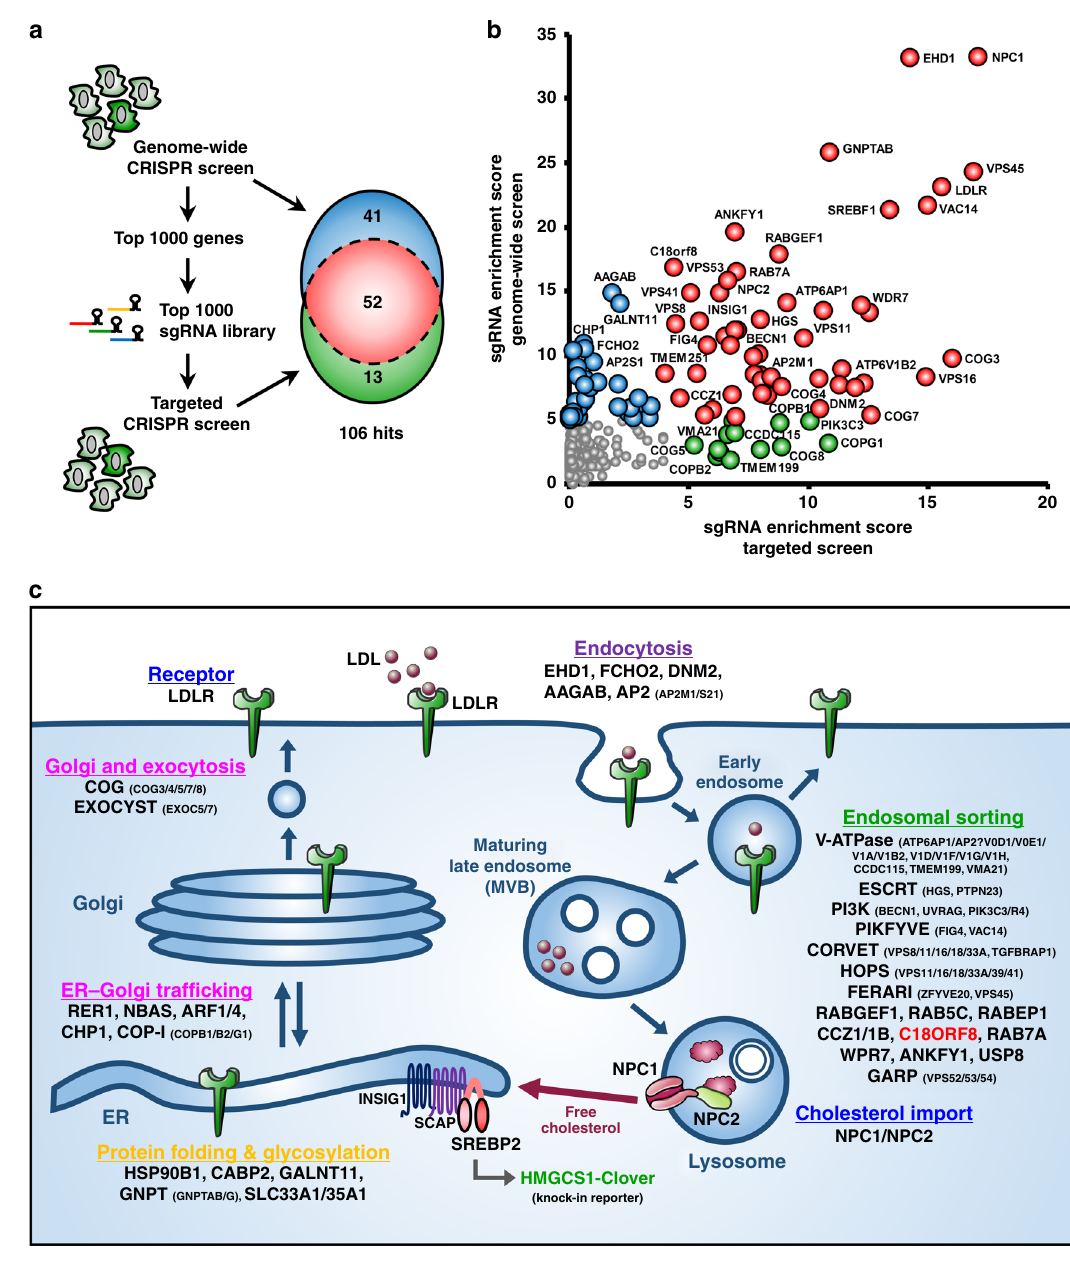
Fig. 2 A secondary sub-genomic CRISPR screen validates genes required for cellular LDL-cholesterol uptake. a Schematic of the primary (genome- wide) and secondary (targeted, top 1000) screening approach. Screening results from both screens show extensive overlap and create a complementary dataset of 106 genes required for cellular cholesterol homeostasis. b Comparison of the genome-wide (vertical) and targeted (horizontal) CRISPR screening results. Genes are indicated by MAGeCK sgRNA enrichment score, with hits speci fi c to the genome-wide screen (score < 10 − 5 ) indicated in blue, hits speci fi c to the targeted screen (score <10 -4 ) in green and hits in both screens in red. A select number of hits is indicated by gene name. The full datasets are available in Supplementary Fig. 2 and Supplementary Data 1. c A schematic representation of combined hits from the genome-wide and targeted CRISPR screens highlights the central role of LDL-cholesterol import in cellular cholesterol homeostasis. Hits are grouped by membrane traf fi cking pathway of their involvement. A full list of hits from both screens is available in Supplementary Data fl uorescence disappeared within 3 h of pulse-labelling, in C18orf8 - increase in LPDS plus mevastatin (blue line). These results show that while wild-type HeLa cells rely predominantly on external de fi cient cells Dil-LDL accumulated during the 3-h chase (Fig. 3e), cholesterol and switch to endogenous biosynthesis when LDL is a phenotype rescued upon complementation with C18orf8-3HA. unavailable, C18orf8 -de fi cient cells are completely reliant on endogenous cholesterol biosynthesis under all conditions. This effect is likely explained by a defect in LDL-cholesterol uptake. C18orf8 -de fi cient cells showed normal LDLR cell surface expression (Supplementary Fig. 4a) and uptake of fl uorescent Dil-LDL (Fig. 3d). However, whereas in wild-type cells Dil-LDL Fig. 4b). C18orf8 -de fi cient cells thus show a general defect in